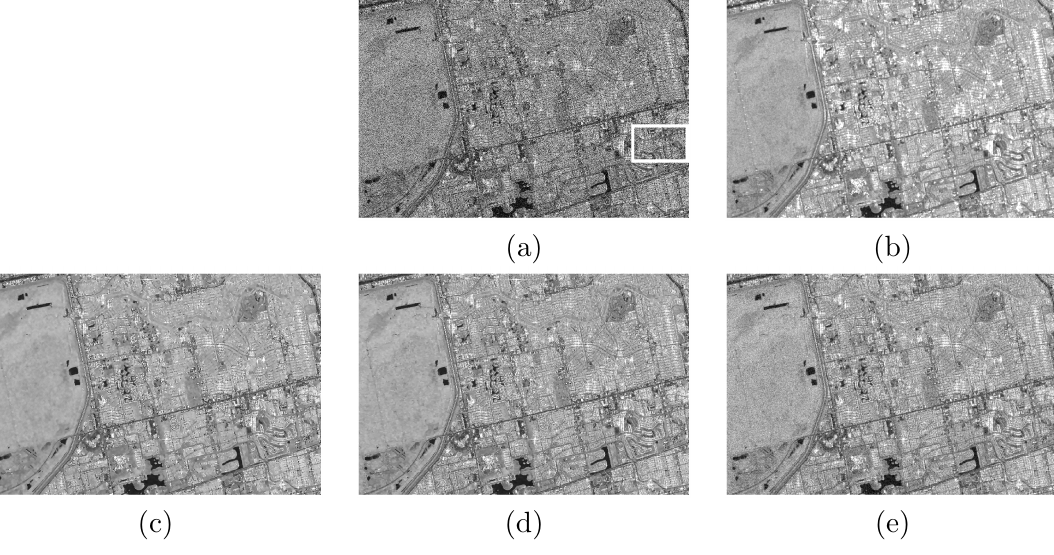
Figure 11. Houston test case: ( a ) Noisy SAR data, and restored images obtained using: ( b ) Kuan, ( c ) PPB-it, ( d ) FANS and ( e )